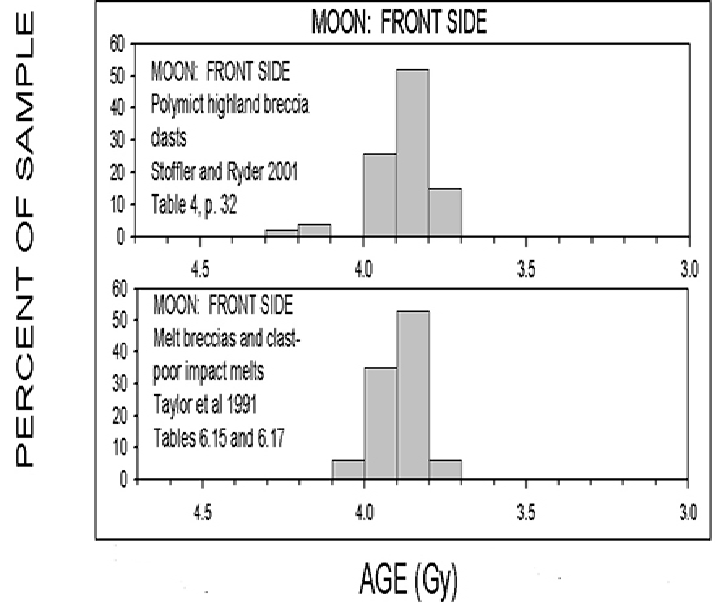
Figure 5. Two diagrams showing impact melt rock age statistics from Apollo samples. Ryder (1990, [11]) presented such data as proof of the existence of cataclysmic bombardment for ~150 Ma around 3.9 Ga ago. Ryder also argued that the relative lack of impact melts from before 4 Ga ago indicated lack of impacts during that time. This “Ryder gap” argument was widely used by later researchers as a base for sample interpretation and dynamical models.